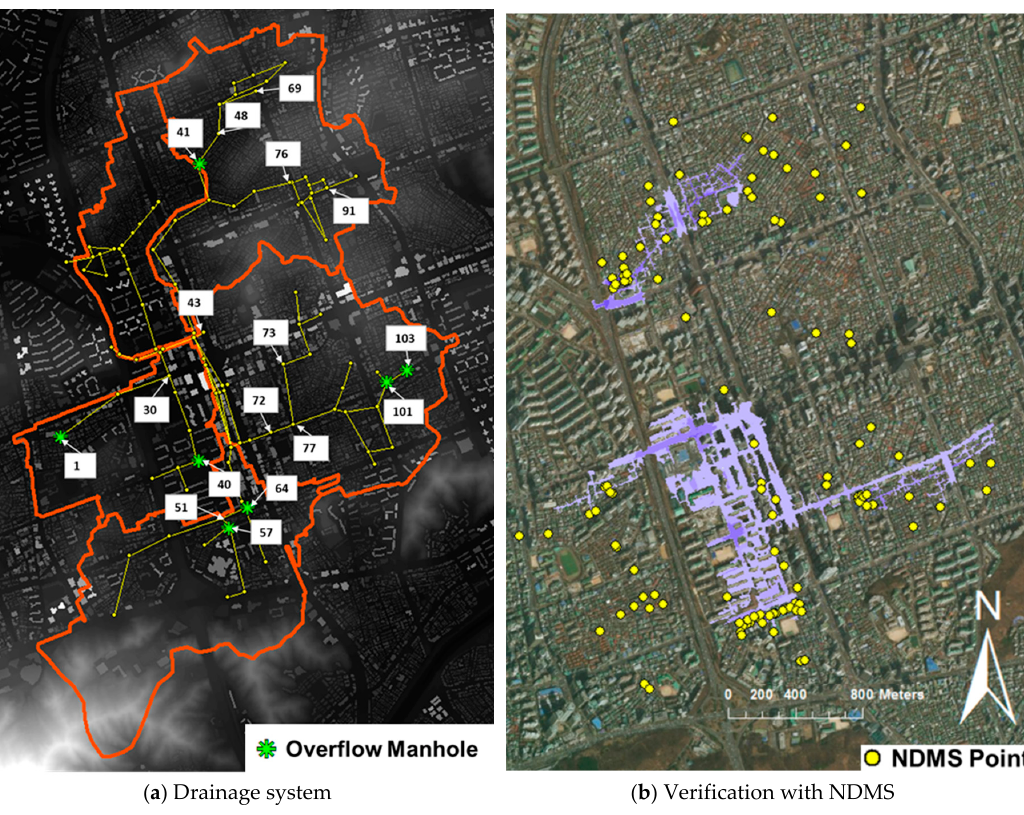
Figure 5. Drainage system ( a ) and 2D inundation model verification ( b ).